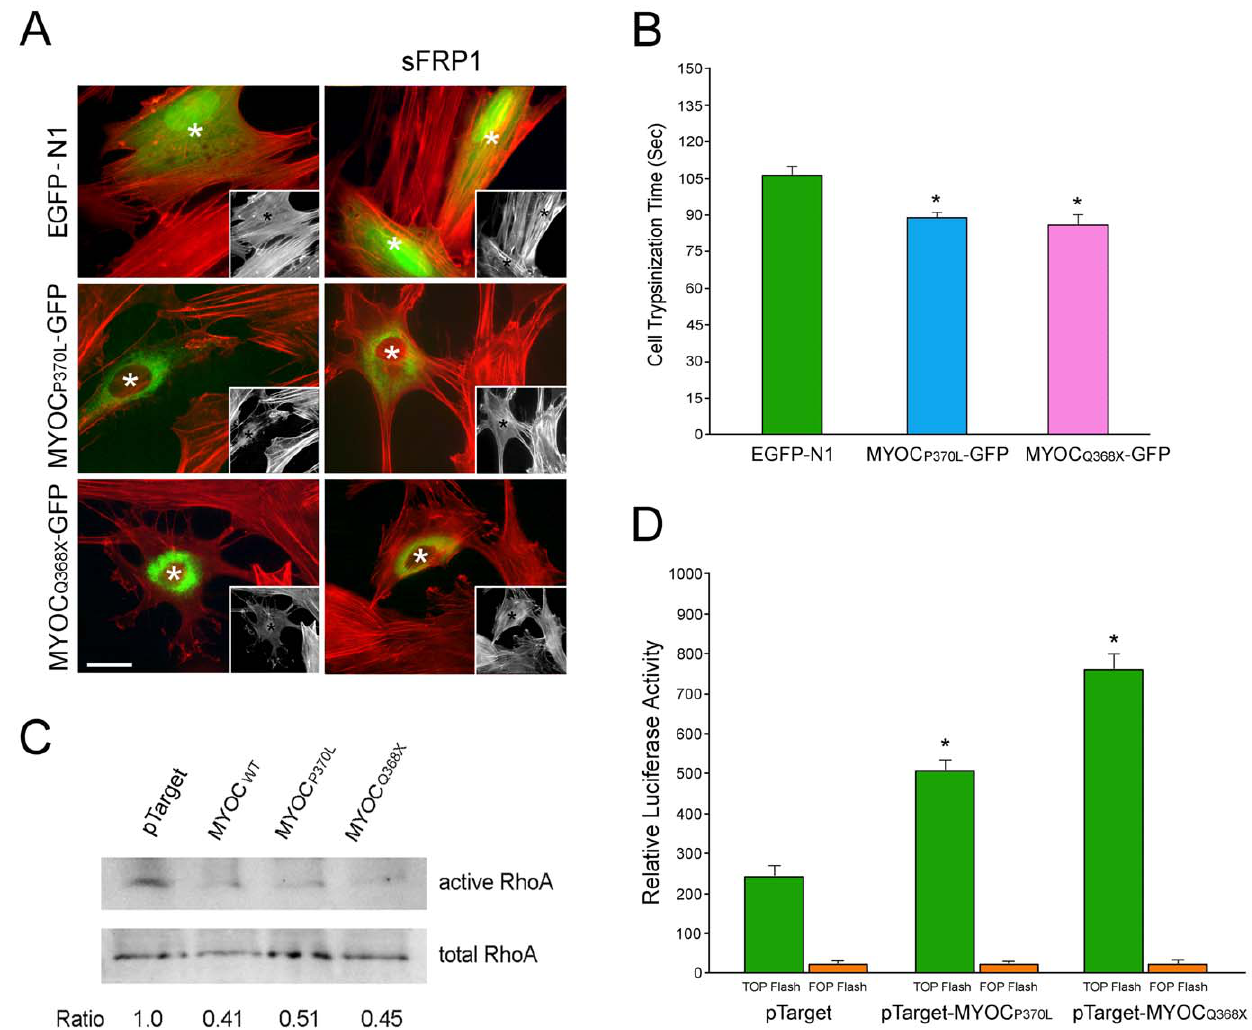
Figure 4. A. Actin (red) staining in pEGFP-N1 (EGFP-N1)-, pMyocilin P370L -EGFP (MYOC P370L -GFP)-, and pMyocilin Q368X -EGFP (MYOC Q368X -GFP)-transfected TM cells without or with subsequent overnight treatment of sFRP1. Insets show the same field in black and white. Transfected cells are marked by green fluorescence, or white or black (in insets) asterisks. Bar, 20 m m. B . The trypsinization time (mean 6 SEM) needed for pEGFP-N1 (EGFP-N1)-, pMyocilin P370L -EGFP (MYOC P370L -GFP)-, and pMyocilin Q368X -EGFP (MYOC Q368X -GFP)-transfected TM cells to become refractile. Asterisk indicates that the trypsinization time for myocilin mutant transfectants was significantly (P , 0.0001, n=30) lower than that of GFP controls. C . GTP-bound active RhoA in pTarget-, pTarget-myocilin WT (MYOC WT )-, pTarget-myocilin P370L (MYOC P370L )- and pTarget-myocilin Q368X (MYOC Q368X )-transfected TM cells. Pull down assays were performed in duplicates to determine the RhoA activity. The amount of the active or GTP- bound RhoA was normalized against the total amount in cell lysates and expressed as mean 6 SD relative to that in pTarget control. The RhoA activity upon myocilin wild type (0.41 6 0.04, n=2) and mutant transfection (0.51 6 0.03 for P370L; 0.45 6 0.04 for Q368X, n=2) was found to be significantly reduced (P , 0.0001) compared to controls. Experiments were repeated two times with similar results. D. Top 2 /Fop-Flash assays. Caco-2 cells were co-transfected with TOP- or FOP-Flash reporter construct, pTarget-myocilin P370L , pTarget-myocilin Q368X , or pTarget, as well as pEGFP-N1. Luciferase activity (mean 6 SEM, n=8) was measured post transfection and was normalized to the GFP level. *, P , 0.001 compared to the